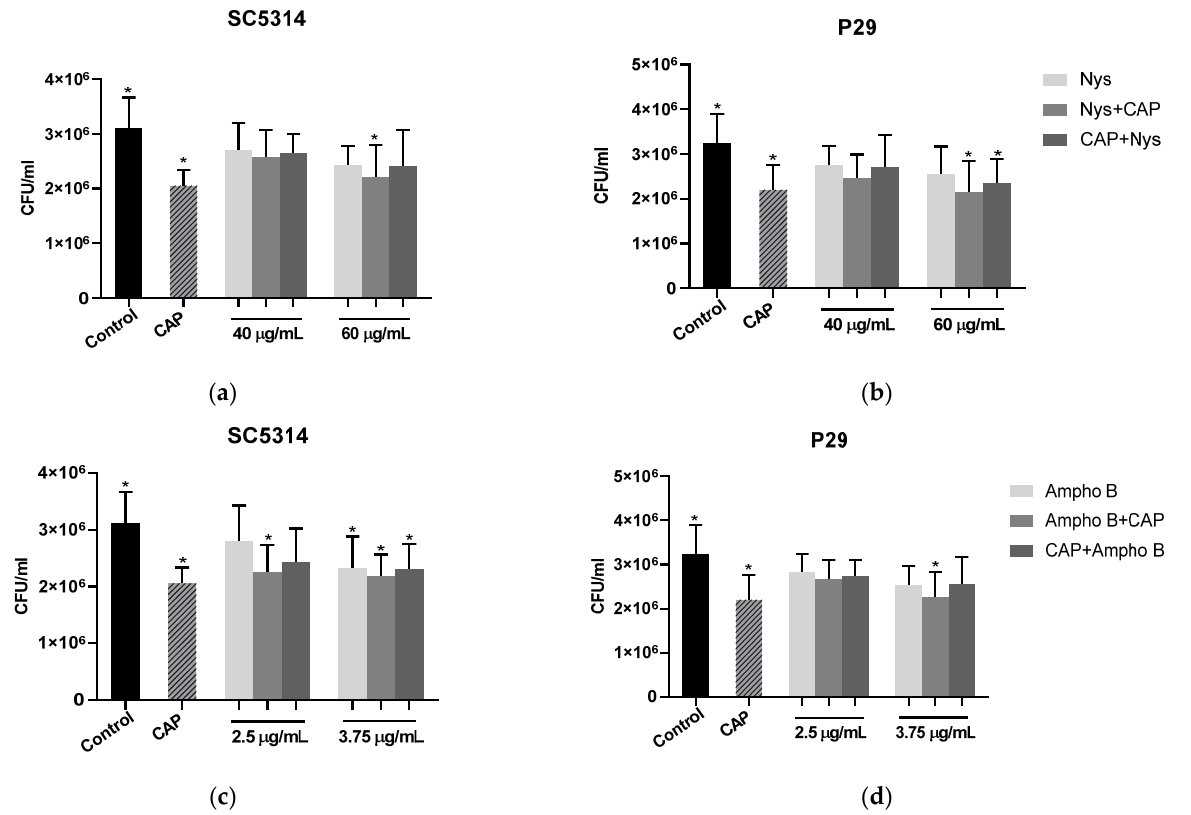
Figure 3. Values of CFU/mL of 48 h biofilms after associated treatments. ( a , b ) = isolated and associated treatments with Nystatin; ( c , d ) = isolated and associated with Amphotericin B. Control = no treatment; CAP = treatment with cold atmospheric plasma. Nys = treatment with nystatin; Ampho B = treatment with amphotericin B; Nys+CAP/Ampho B+CAP = previous treatment with nystatin or amphotericin B; CAP+Nys/CAP+Ampho B = previous treatment with CAP. (*) indicate significant differences ( p < 0.05) between the groups and the control.